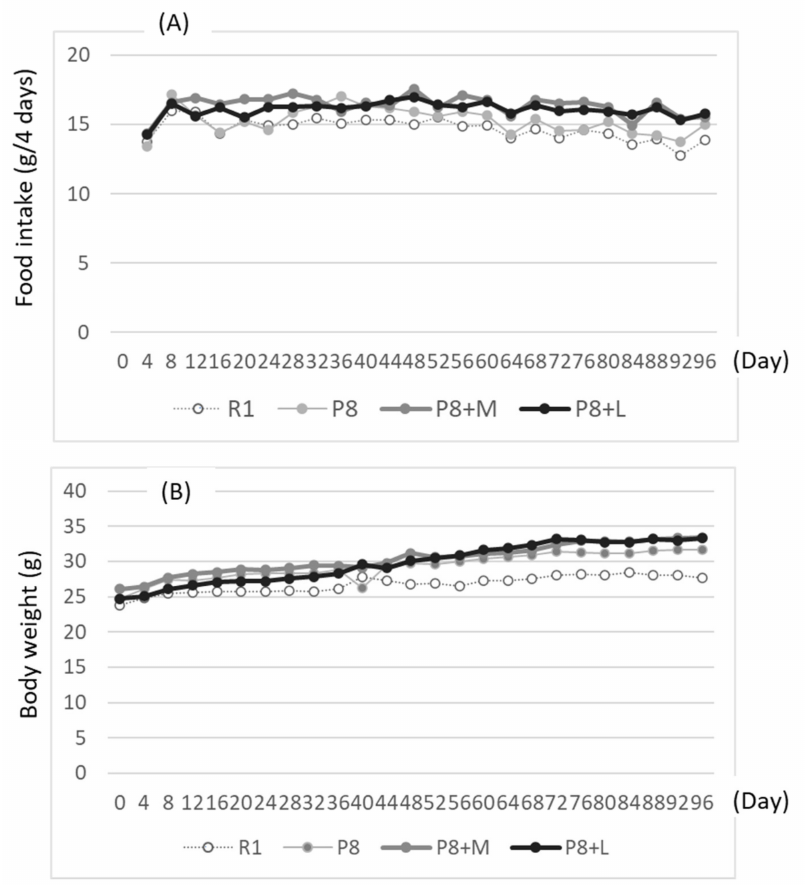
Figure 1. Effects of dietary matcha and decaffeinated matcha on food intake every 4 days ( A ) and body weight ( B ). R1: senescence-accelerated-resistant mice (SAMR1) group fed with basal diet;